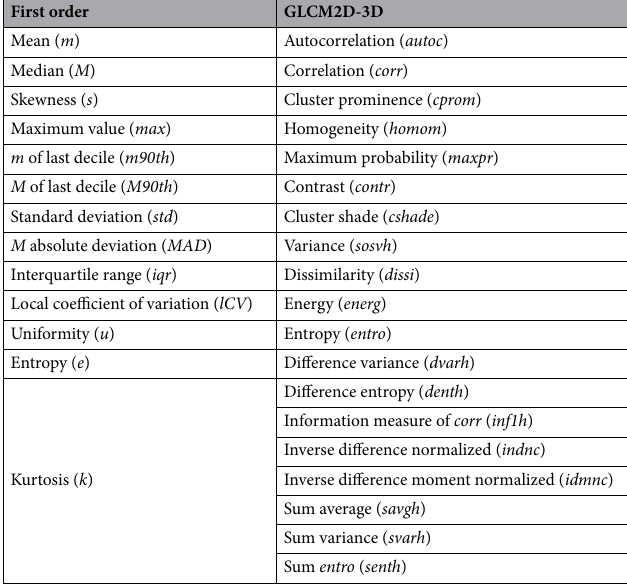
Table 2. List of first order (n=13) and GLCM2D-3D (n=19) features.